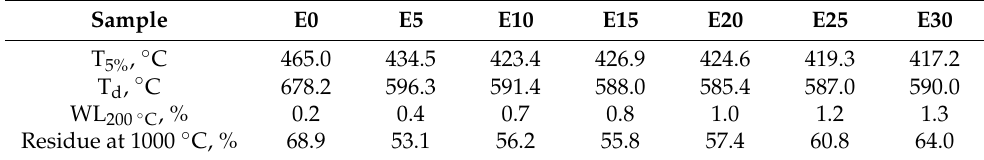
Table 3. Thermogravimetric data of